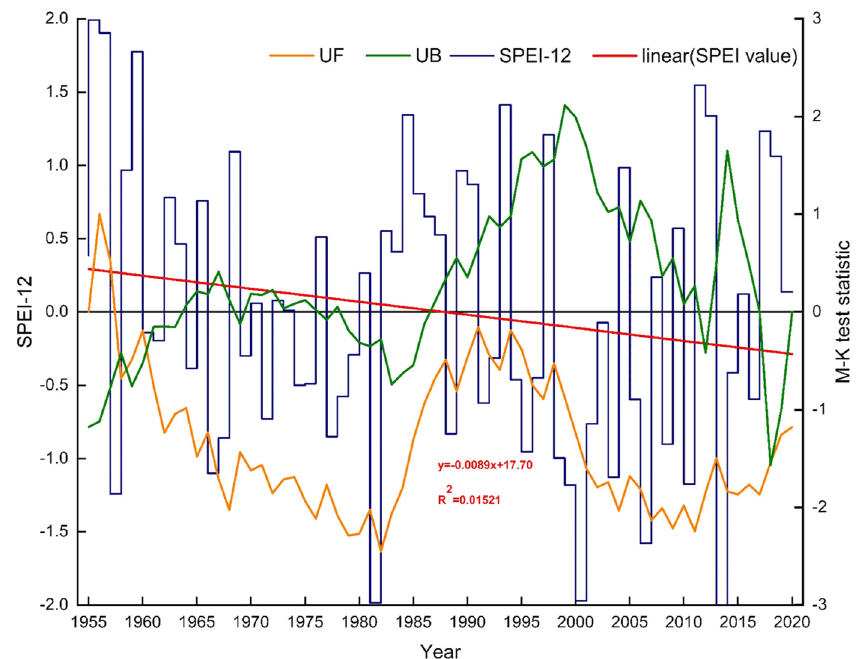
Figure 3. Characteristics of interannual variation of SPEI − 12 in study area from 1955 to 2020.